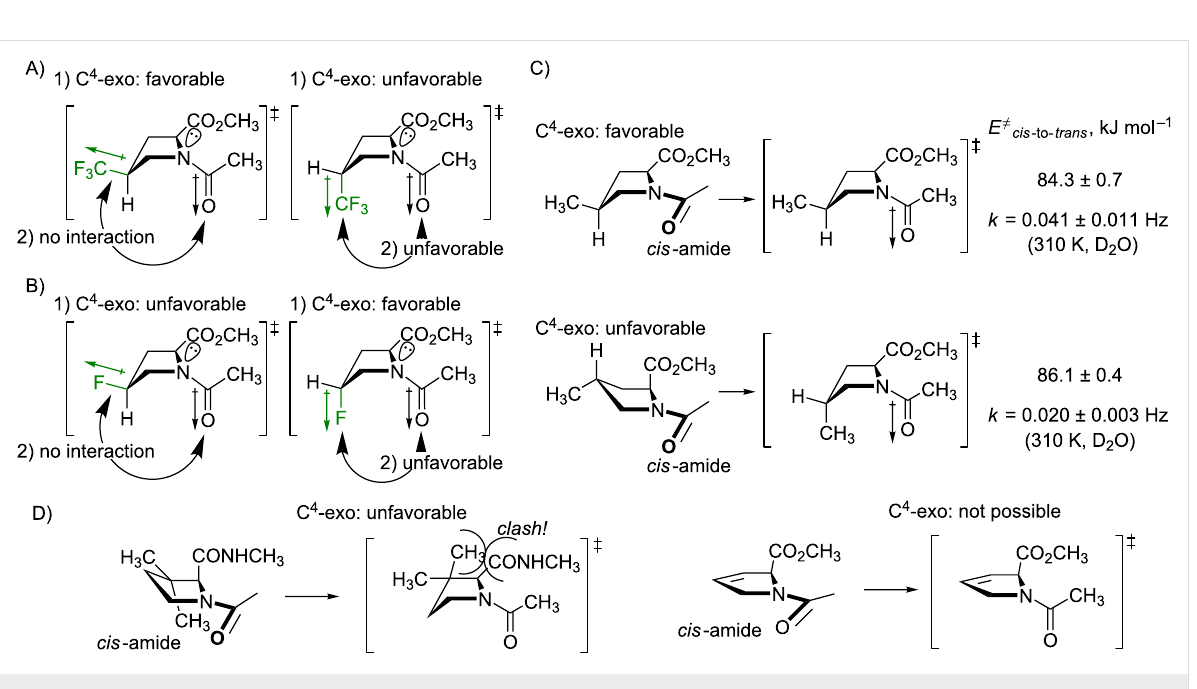
Figure 9: The explanation for the difference in the rotation barriers in the diastereomeric (A), 4-(trifluoromethyl)prolines (B) 4-fluoroprolines, and ( C) 4-methylprolines. D) The two known cases with the increase of the barrier of rotation in proline analogues.